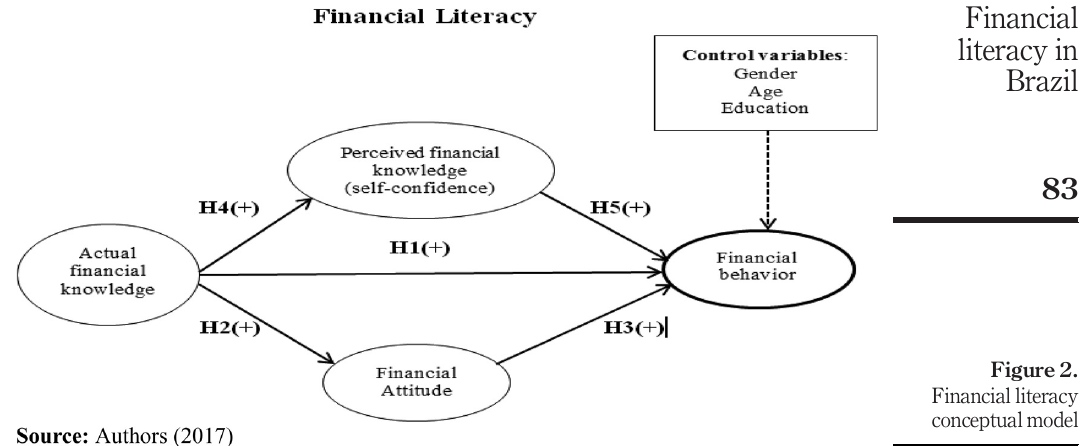
Figure 2. Financial literacy conceptual